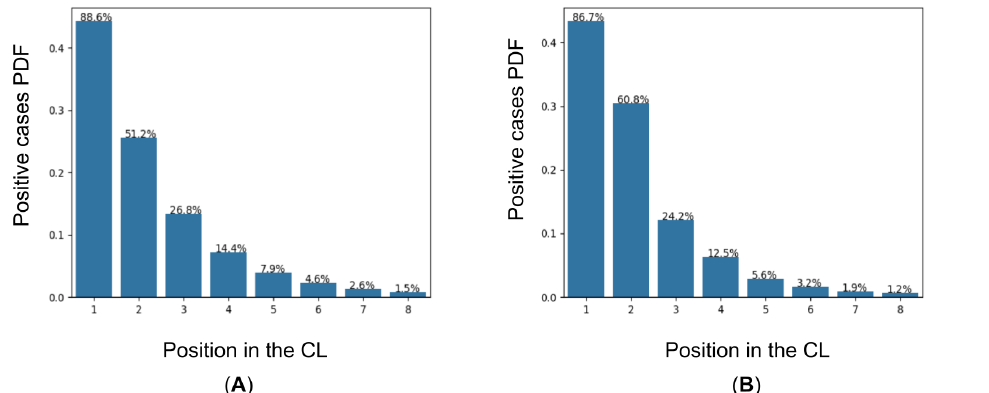
Figure 2. Empirical Probability Density Function (PDF) showing the optimal edge behavior in relation to the position in the CL. Over each bar is shown the rate of optimal edge occurrence for each considered position. ( A ) Evaluation data-set. ( B ) TSPLIB